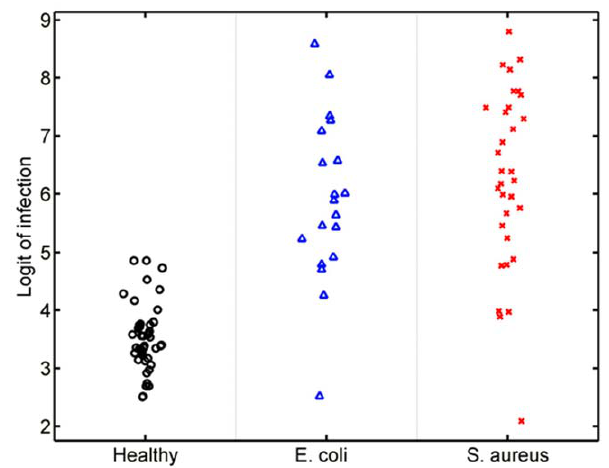
Figure 5. Projecting the mouse S.aureus classifier onto human subjects. The murine S. aureus classifier identifies humans with S. aureus BSI, but does not differentiate S. aureus from E. coli BSI.